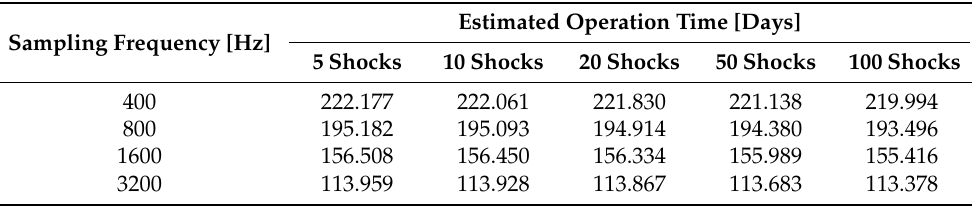
Table 3. Estimated Smart Sticker operation time based on current consumption measurements in low-power and active mode for a different number of measured shocks per